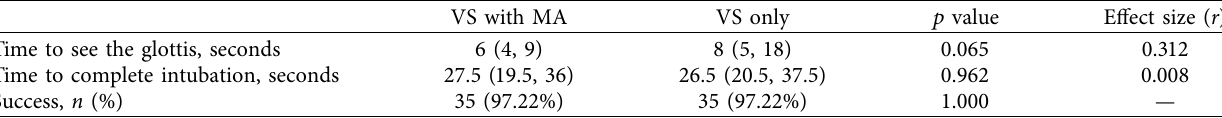
Figure 4: Kaplan–Meier plot of devices with or without use of modified airway. FOB: fiberoptic bronchoscope; VS: video stylet; MA: modified airway. (a) FOB+MA vs. FOB, (b) VS +MA vs. VS, (c) VS vs. FOB, and (d) VS +MA vs FOB+MA. Table 3: Comparison of video stylet with modified airway and video stylet